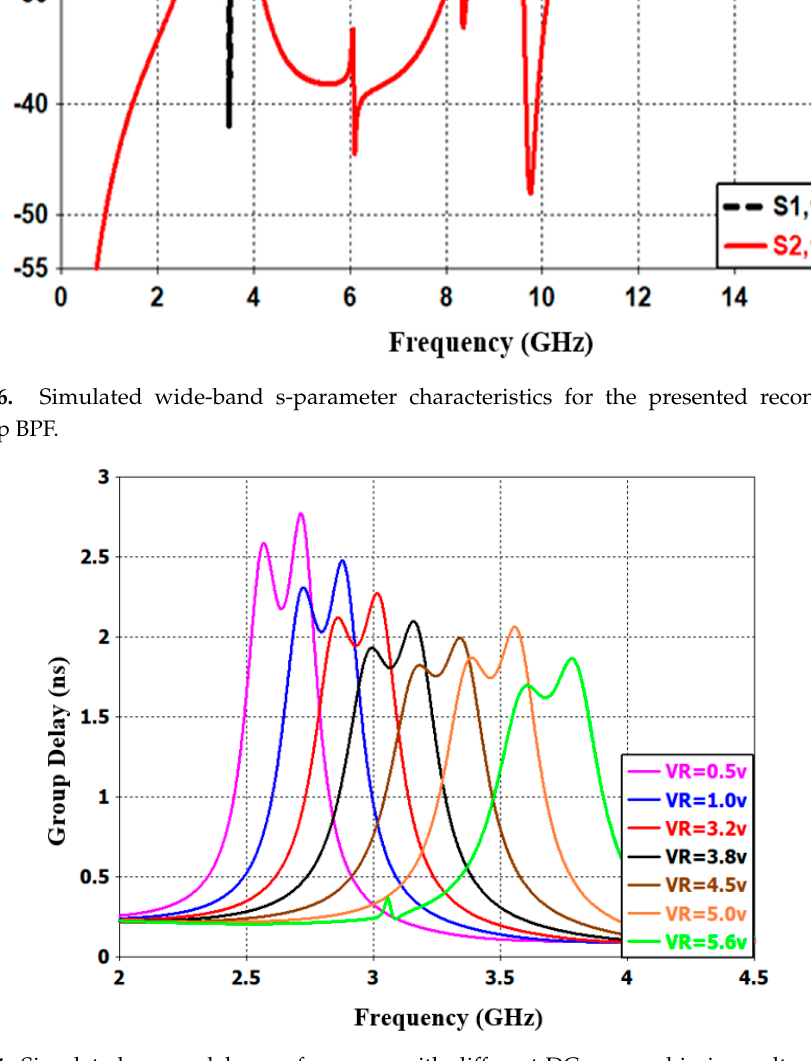
Figure 18. Simulated phase characteristics of S 21 with different DC reverse bias voltages for the presented reconfigurable microstrip BPF. It should be noted that with the rapid development of current 4G and 5G applications, a compact, efficient and reconfigurable planar filter with a wide tuning range is in huge demand. Designing a tunable filter that covers both 4G and 5G spectrum using the same configuration will also be required for several wireless applications. According to what is shown, the proposed tunable filter can offer these requirements, where the design has a very compact size and operates at a centre frequency range from 2.5 GHz (4G) to 3.8 GHz (5G) with a very low insertion loss of 0.8 dB. Moreover, Table 1 shows the comparative performance of the presented reconfigurable microstrip BPF with other, similar designs from the literature. It is shown that the reported filter has a wider tuning range and wider impedance bandwidth, smaller insertion losses and a smaller size compared to the designs presented in [56,57,59–62]. The tunable filters presented in [60,61] have an impedance bandwidth of only 40 MHz. The presented tunable filter and the filter introduced in [62] use only two varactor diode switches and a simple basing circuit to achieve the tunable frequency characteristics. As a result, the filter presented in this work has a relatively very good performance in terms of